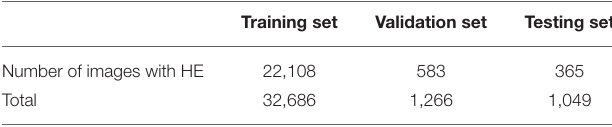
TABLE 2 | The number of images were annotated HE lesions by ophthalmologists in the private